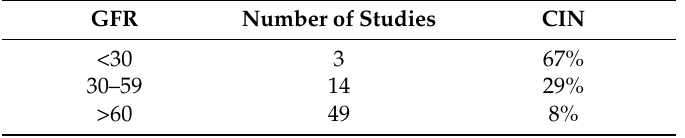
Table 4. Percentage of patients who developed